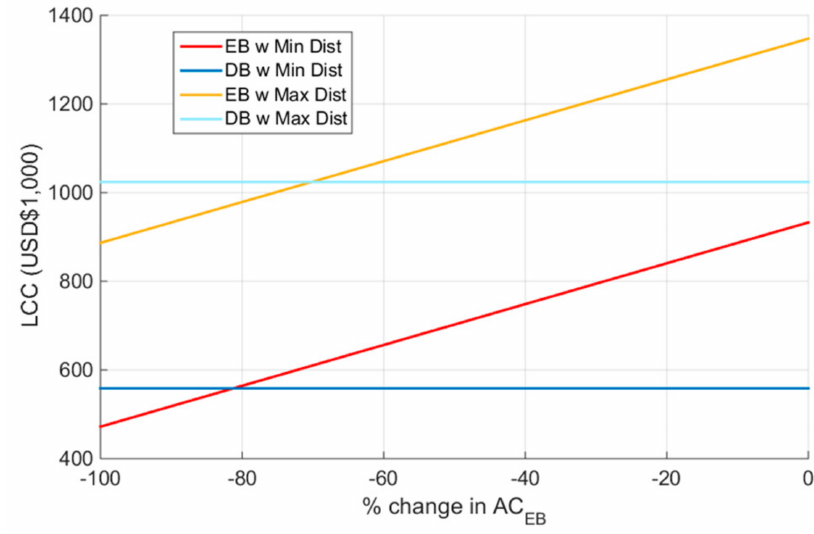
Figure 5. LCCs of the electric and diesel buses, against the percentage change of the AC of EB.